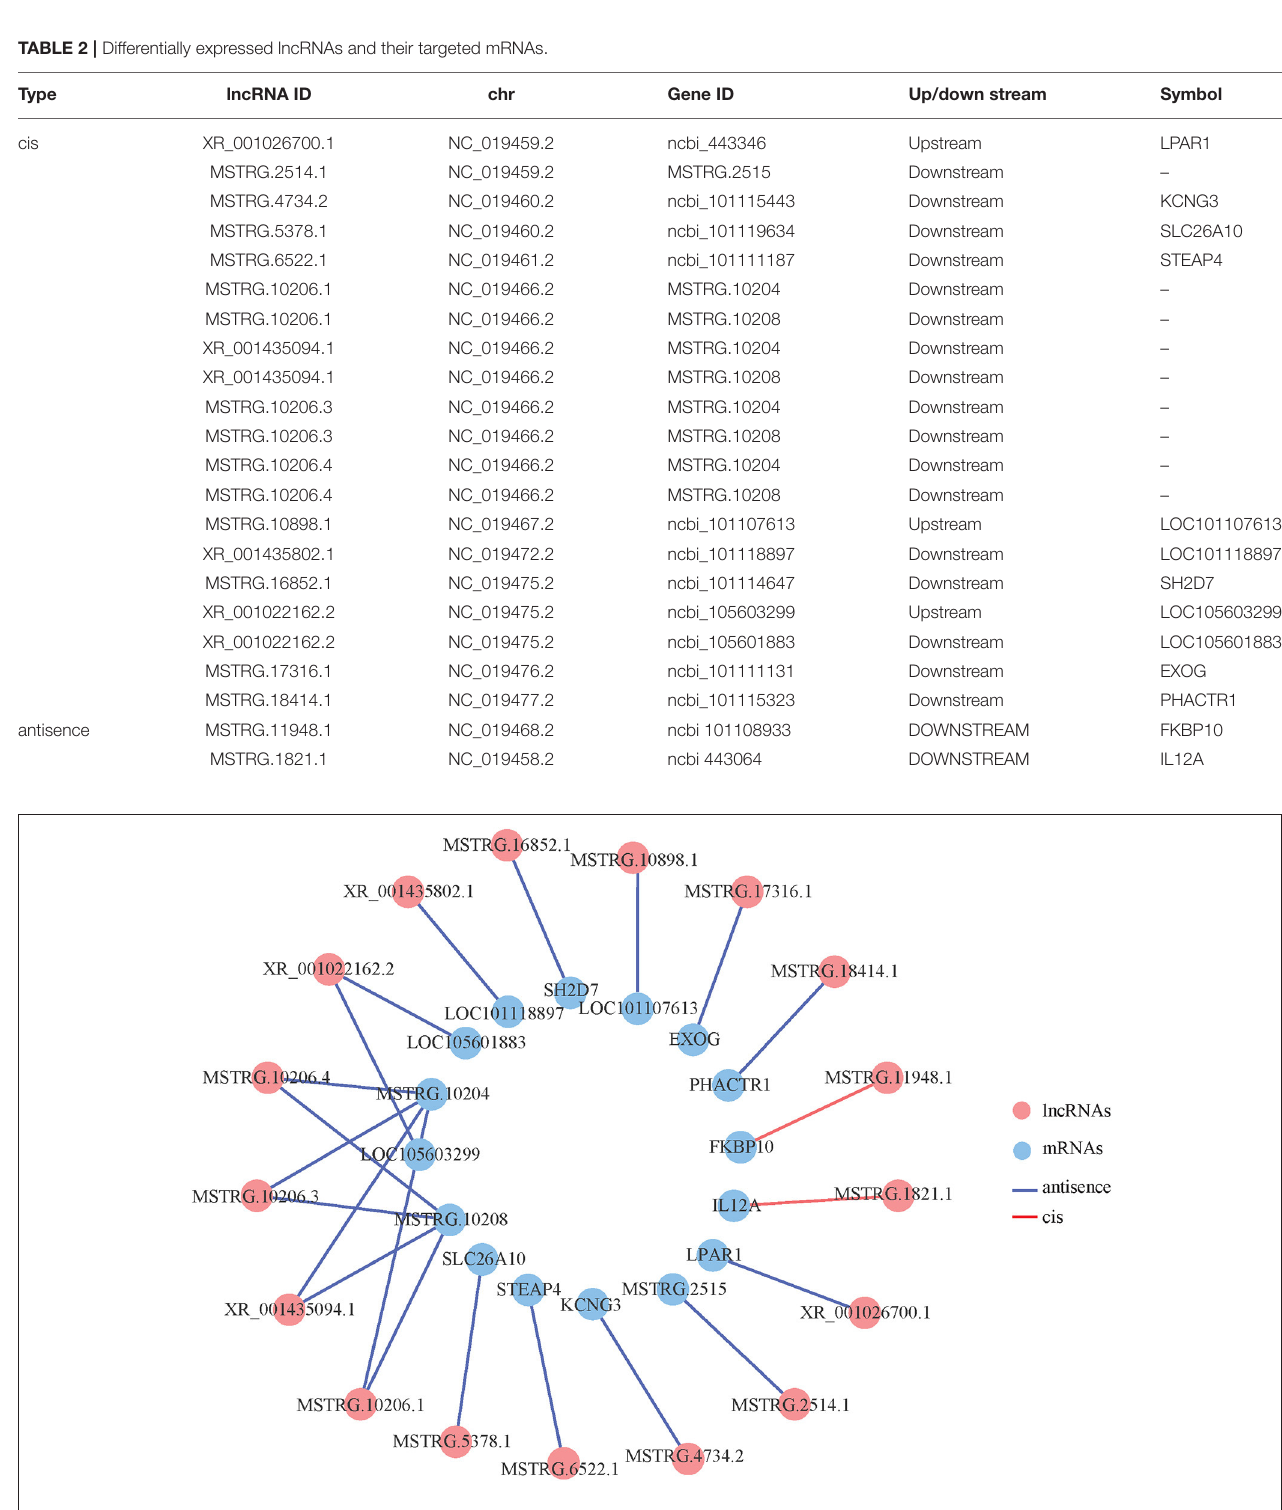
Under hypoxic stress, different areas of the body show